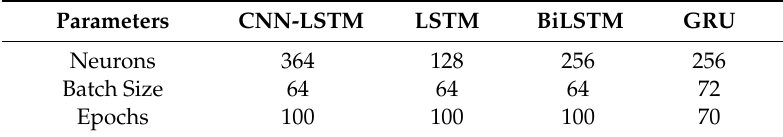
Table 2. Parameters of the remaining neural networks for comparison with